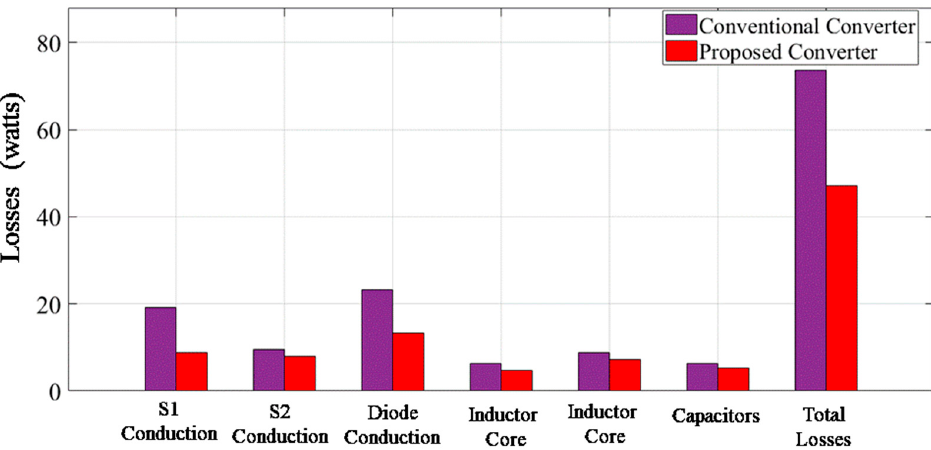
Figure 20. Power loss comparison of proposed converter with traditional converter.